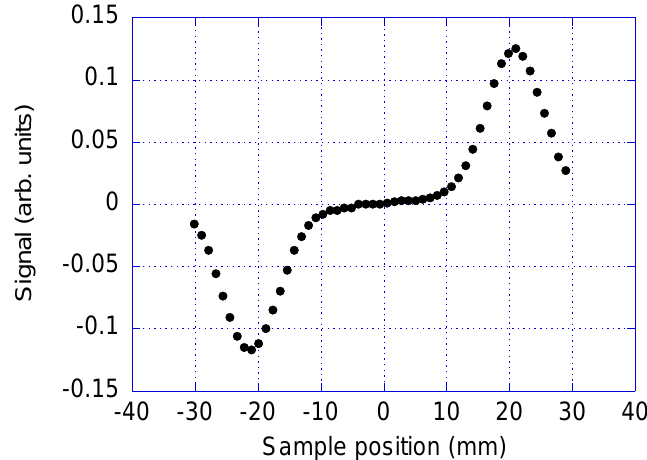
Figure 3. Signal (in-phase component of the AC susceptibility) versus sample position (relative to the coil system). Zero sample position is in the center of the baseline connecting the two detection coils.